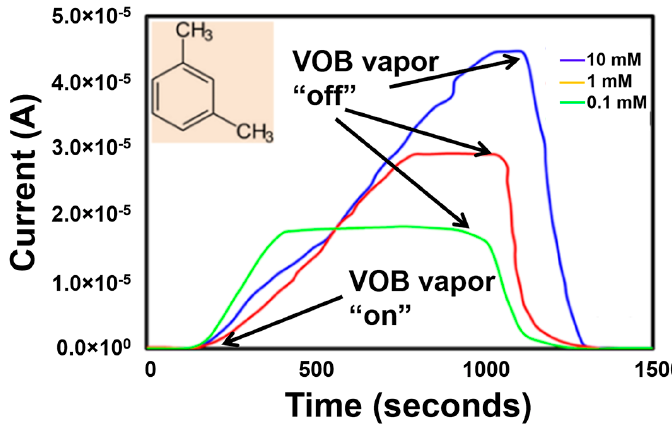
Figure 7. Sensor current response of Ni-TNA to vapors of 1,3-dimethylbenzene at different concertation in ethanol solution, arrows show the point when the sensor exposure to the VOB was started and removed.